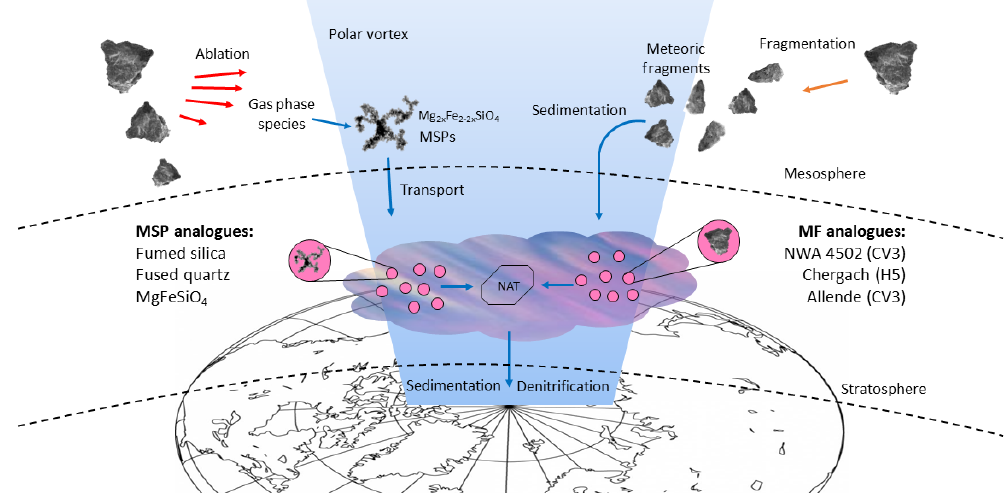
Figure 1. The pathways of two kinds of meteoric material through the atmosphere. Processes are shown which lead to formation of meteoric smoke particles (MSPs) and meteoric fragments (MFs), either of which could heterogeneously nucleate nitric acid trihydrate (NAT) in polar stratospheric